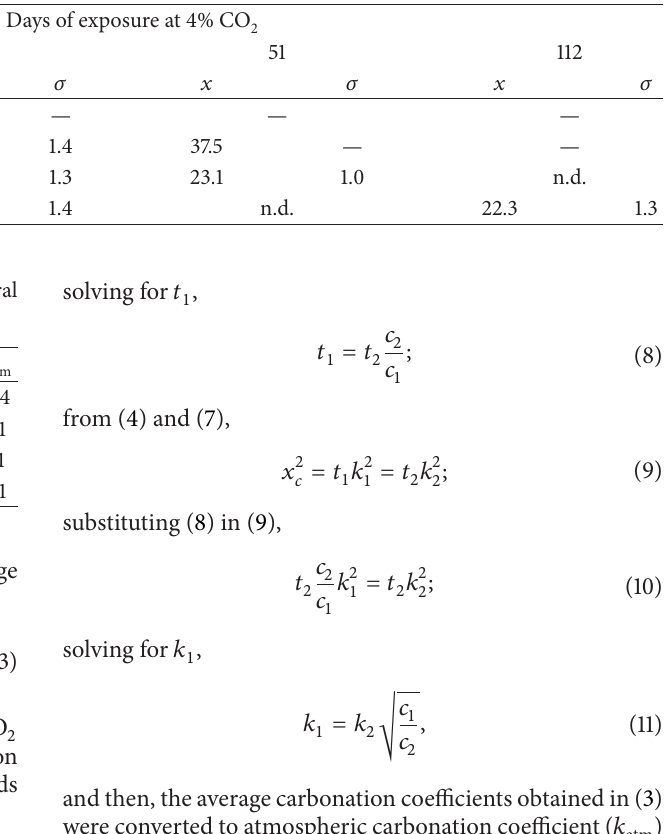
Table 4: Carbonation depth measurements and standard deviations (mm).